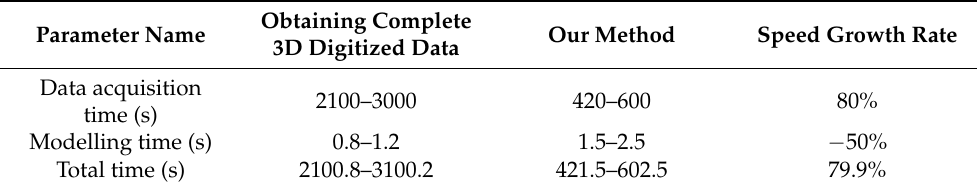
Table 7. The total time consumption of this method compared with that of the 3D digitizer to obtain complete plants for 3D